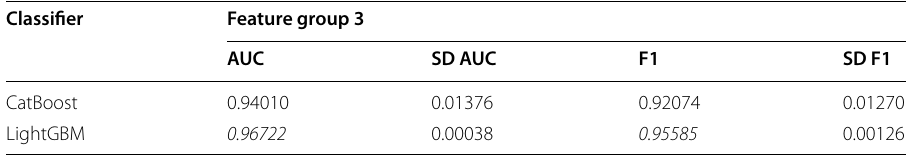
best metrics are highlighted in italics; SD AUC is the standard deviation of AUC and SD F1 is the standard deviation of the F1-score Table 23 Mean performance of CatBoost and LightGBM in terms of AUC and F1-score on datasets with features from feature group 4